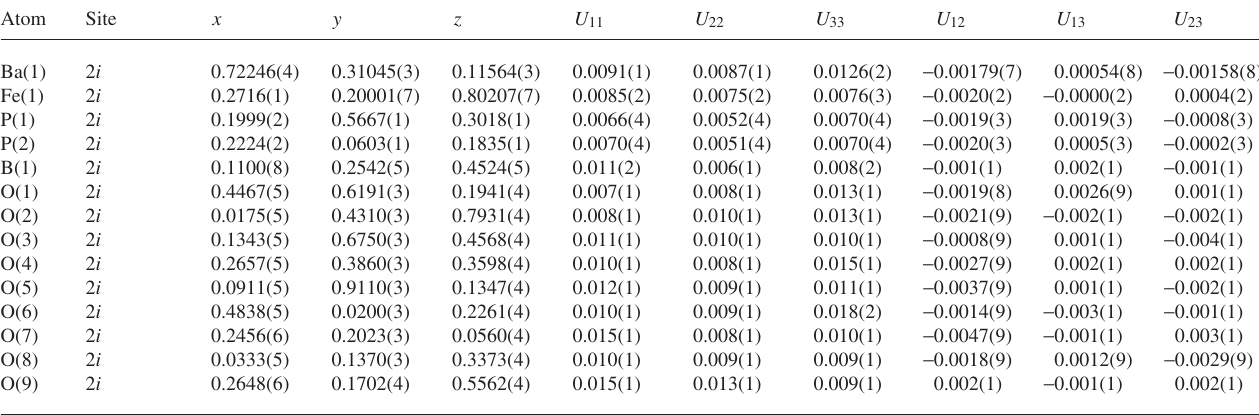
Table 2. Atomic coordinates and displacement parameters (in Å 2 )